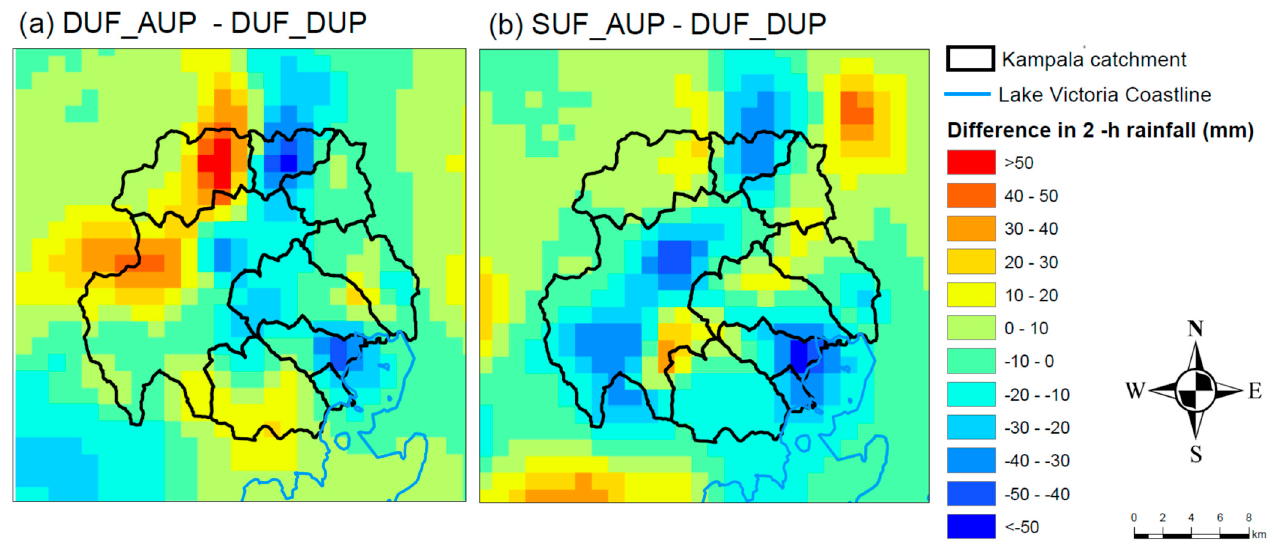
Figure 7. 2 h accumulated rainfall difference for the period of 11:00–12:50 UTC on 25 June 2012 (the same period as the observed rainfall using AWS in Kampala): subtractions of DUF_DUP simulation from ( a ) DUF_AUP and ( b ) SUF_AUP simulations.